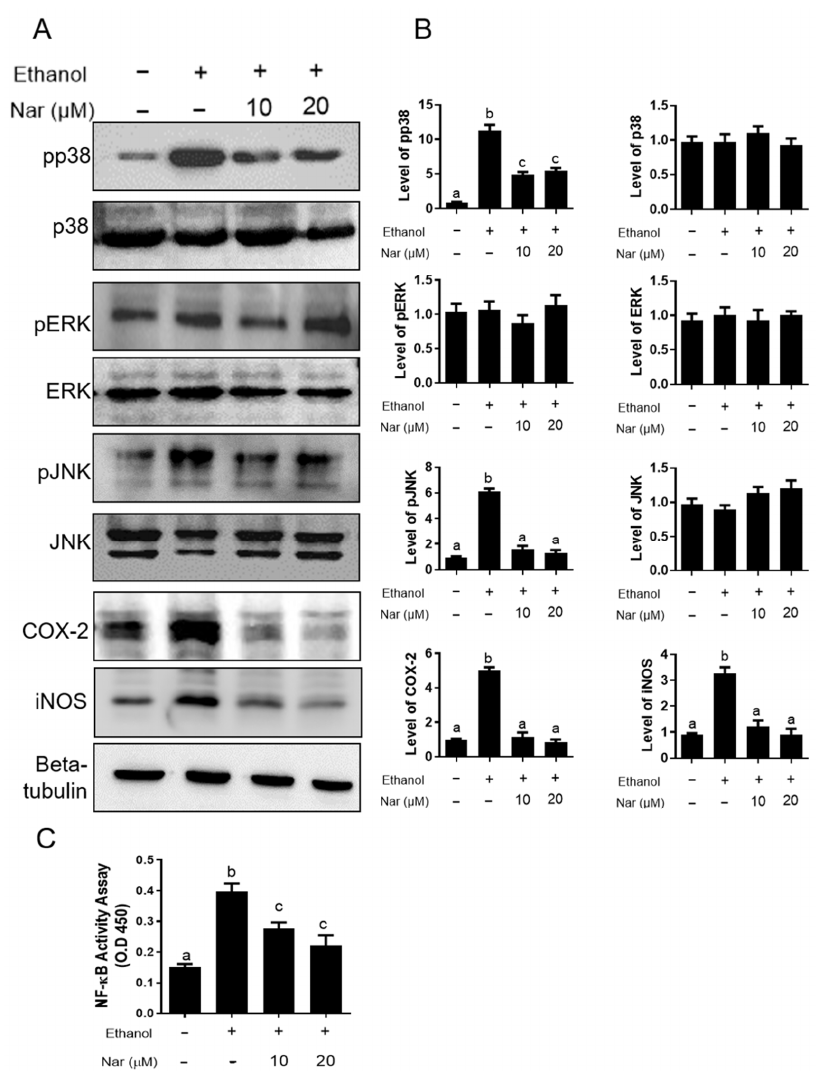
Figure 6. Phosphorylation of MAPKs and translocation of NF- κ B p65 in ethanol-stimulated KATO III. ( A ) Levels of phosphorylated p38 MAPK, ERK, JNK, COX-2 and iNOS from ethanol-stimulated KATO III cellular lysates in the absence or presence of naringenin (Nar, 10 and 20 µ M). Representative